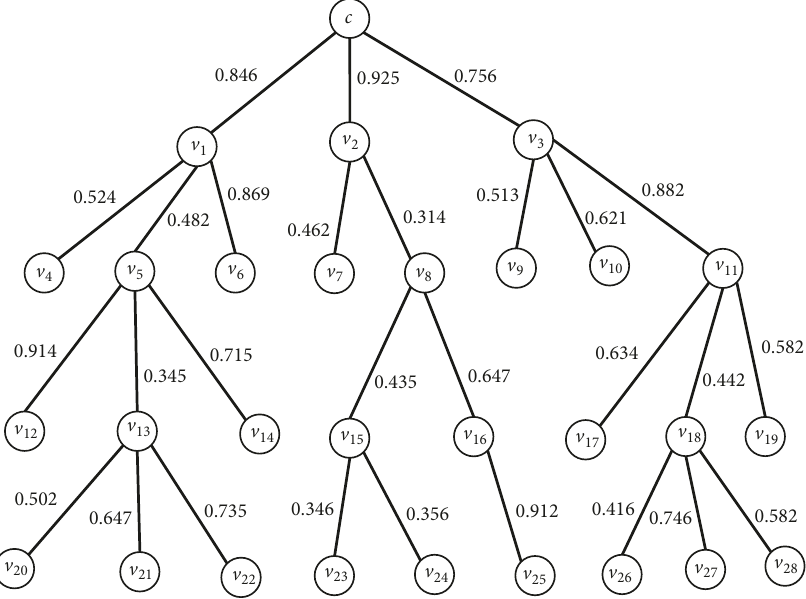
Figure 3: A rooted tree network 𝑇 𝑐 with 29 vertices and 28